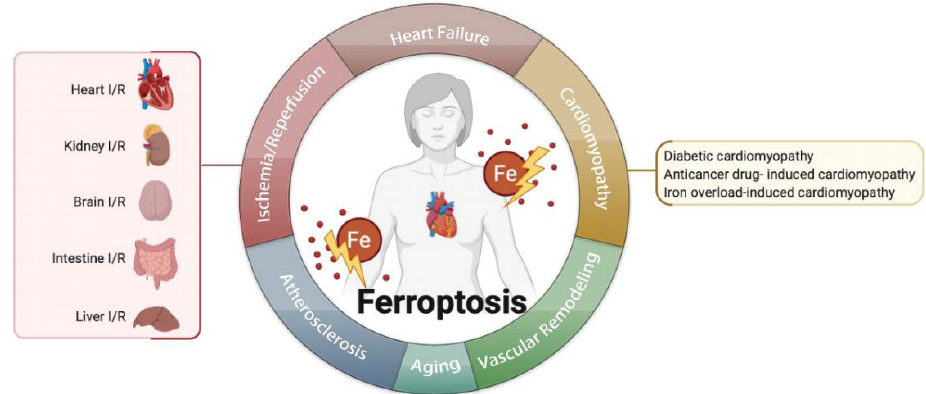
Figure 2. Ferroptosis is related to multiple cardiovascular diseases, such as ischemia/reperfusion, heart failure, cardiomyopathies, atherosclerosis, aging, vascular remodeling, and so on.